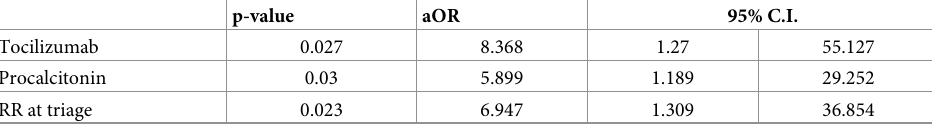
Table 4. Logistic regression: Factors associated with in-hospital mortality in COVID-19 oncology patients. p-value aOR 95% C.I. Tocilizumab 0.027 55.127 Procalcitonin RR at triage 0.023 36.854 Variables entered in model: Vasopressors, Tocilizumab, Treatment with steroids in ED, Anticoagulants in ED, C- reactive protein, procalcitonin, Chemotherapy within 1month of presentation, respiratory rate at triage (reference: RR < 22), O 2 triage (reference: O 2 saturation >